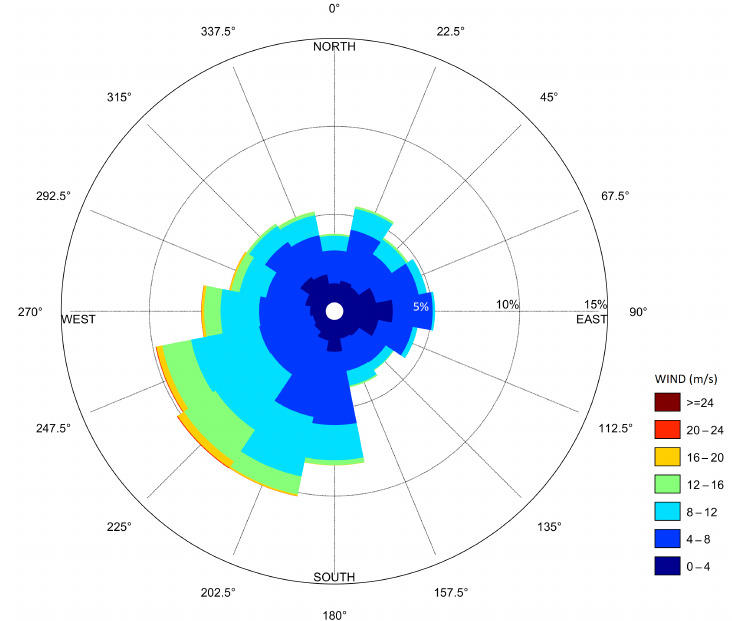
Figure 8. Measured wind rose at Container